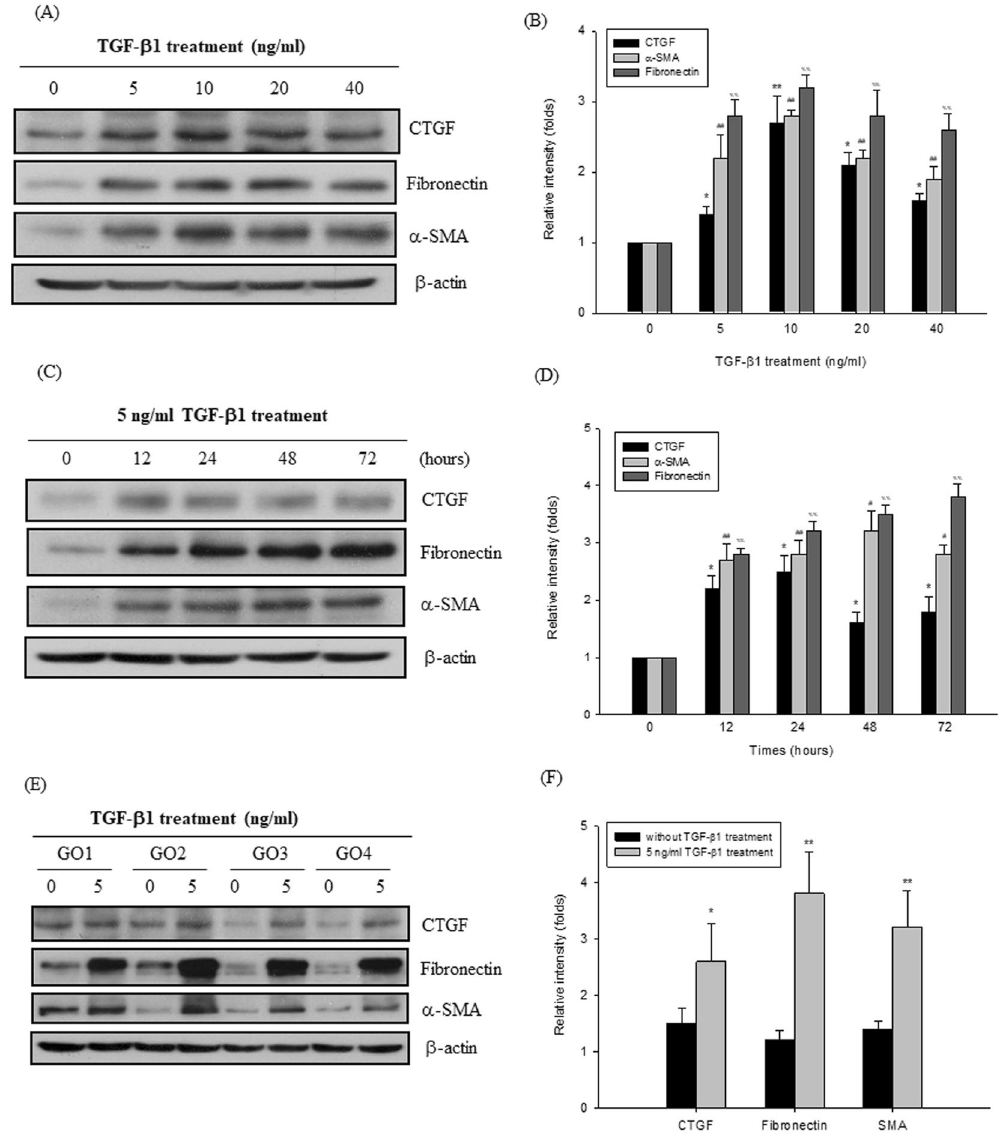
Figure 2. TGF- β 1-induced up-regulation of fibrosis-related proteins in the GO orbital fibroblasts. ( A ) After treatment of the orbital fibroblasts from GO1 patient with 5, 10, 20 and 40 ng/ml TFG- β 1 for 24 hours, the proteins expression of CTGF, fibronectin, and α -SMA were examined by Western blots, and ( B ) the densitometric scan analysis of three independent Western blots for the fold change of protein expression level was constructed as a bar graphic. Data are presented as means ± S.D. ( C ) After treatment of the orbital fibroblasts from GO1 patient with 5 ng/ml TFG- β 1 for 12, 24, 48 and 72 hours, the proteins expression of CTGF, fibronectin and α -SMA were examined by Western blots. ( D ) The representative bar graphic was constructed from three independent experiments, and data are presented as means ± S.D. ( E ) After treatment of the GO orbital fibroblasts from four GO patients (GO1-GO4) with 5 ng/ml TFG- β 1 for 24 hours, the proteins expression of CTGF, fibronectin and α -SMA were examined by Western blots, respectively. ( F ) The ratio of CTGF, fibronectin, and α -SMA expression to each β -actin control from GO1 without TGF- β 1 treatment were defined as 1.0, and thus the other relative intensity (folds) were presented, respectively. By three independent Western blots experiments, we averaged together data from the same patient strain, and then average the means of the different patient (GO1-GO4, N = 4) strains. The representative histogram was constructed on the basis of the mean values of proteins expression levels in orbital fibroblasts of 4 GO patients, and presented as means ± S.D. ( * p < 0.05 vs. control without TGF- β 1 treatment; ** ,##,%% p < 0.01 vs. control without TGF- β 1